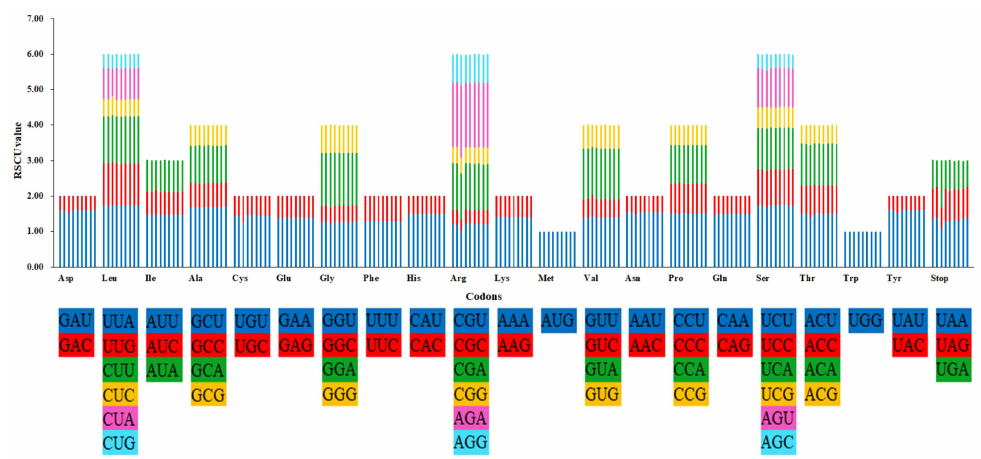
Figure 3. Codon content of 20 amino acids and stop codons in all protein-coding genes of the plastid genomes of E. wushanense and its closely related species. The histogram from the left to right side represents plastid genomes of E. wushanense (HBXS, HBXS-2), E. borealiguizhouense , E. chlorandrum , E. mikinorii (HBES, GZLS), E . pseudowushanense (GZJH, GZNW) and E. ilicifolium ,